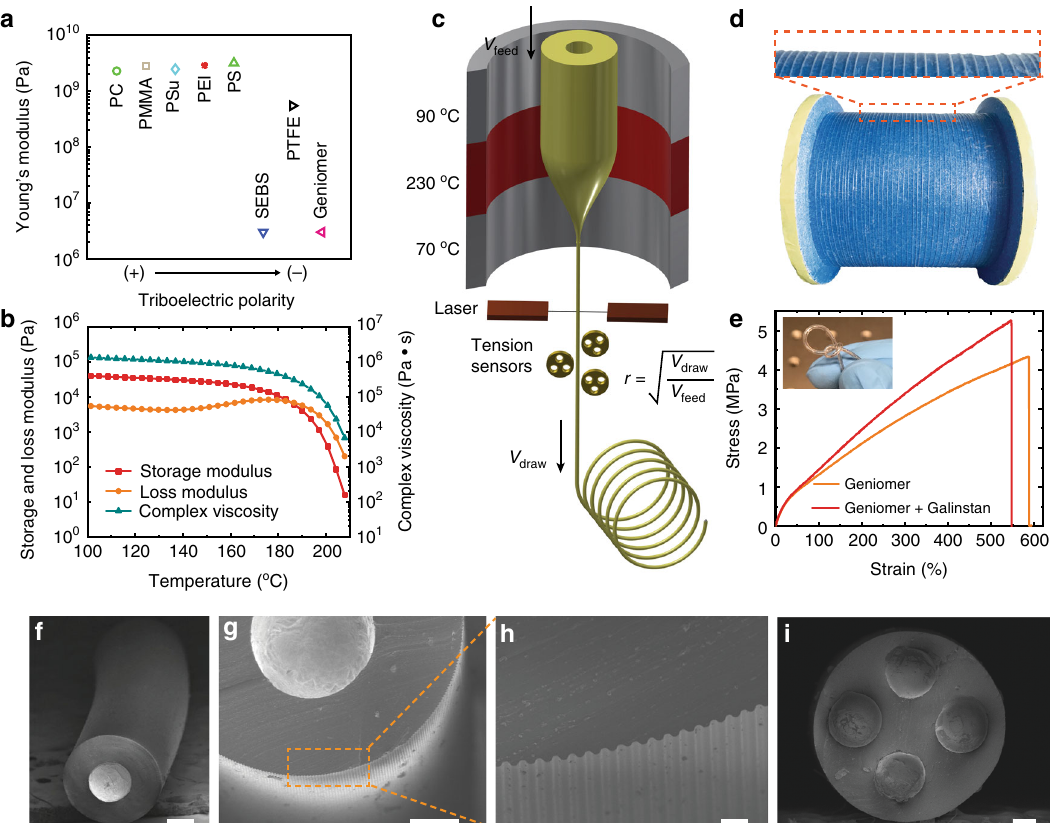
Fig. 1 Materials characterization and fi ber fabrication. a Comparison of Young ’ s modulus and relative triboelectric polarity of electrical insulating polymers that are compatible with the thermal drawing process. PTFE is also listed for a better comparison. b Rheological properties of Geniomer: storage modulus (G ’ ), loss modulus (G ” ), and complex viscosity. c Schematic showing thermal drawing process for the production of long fi bers. d A roll of 40 m of continuous fi ber obtained from a single draw, demonstrating the scalability of drawing process. e Stress – strain curves of a fi ber without and with an embedded liquid metal electrode. The inset shows a fi ber being randomly knotted. f SEM image of a fi ber with a single liquid metal electrode. Scale bar: 200 μ m. g , h SEM image of a fi ber with microtextured surface. Scale bar: 200 μ m ( g ) and 20 μ m ( h ). i SEM image showing a fi ber with four liquid metal electrodes. Scale bar: 200 μ m. Note the abbreviations of the polymers in a : PC polycarbonate, PMMA poly(methyl methacrylate), PSu polysulfone, PEI polyetherimide, PS polystyrene, SEBS poly(styrene- b -(ethylene- co -butylene)- b -styrene), PTFE polytetra fl